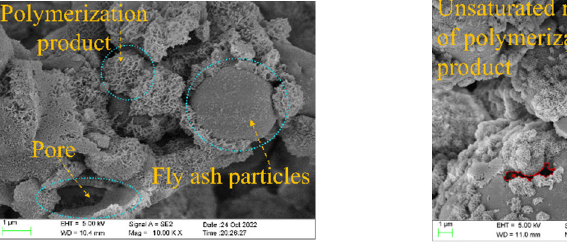
Figure 16. Pore defects between hydration products inside the material.